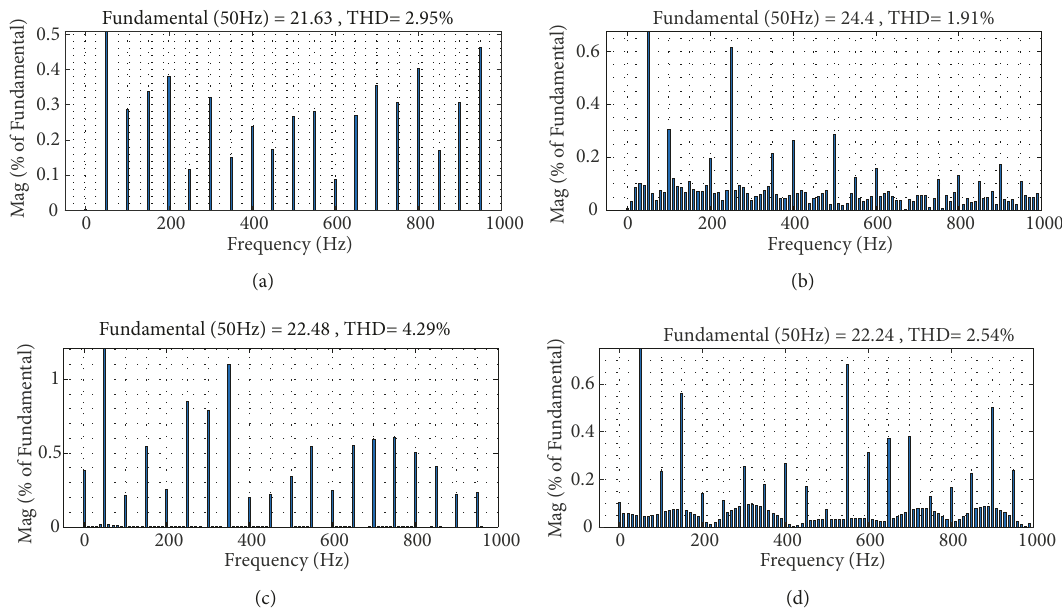
Figure 8: Total harmonic distortion of grid current at 50 𝜇 s sampling time for (a) the conventional MPVC, (b) the proposed MPVC, (c) the conventional MPCC, and (d) the proposed MPCC.